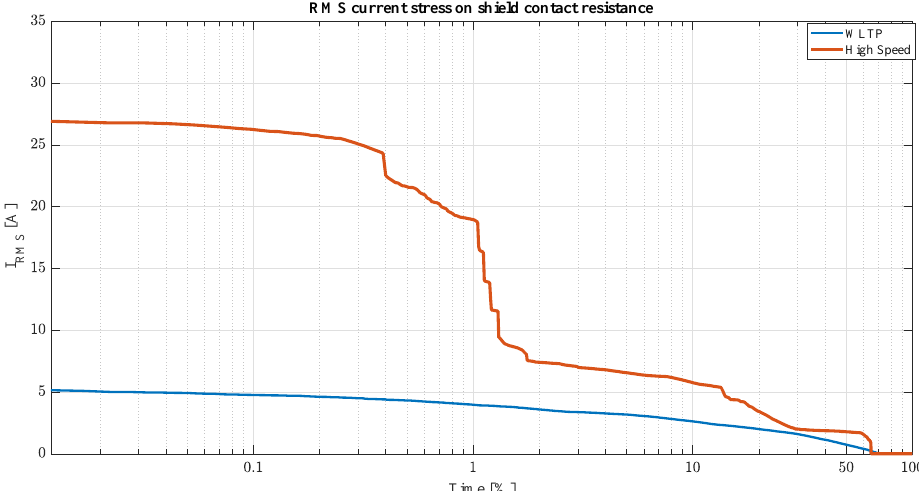
Figure 13. Simulated current levels of HV system currents over a WLTP-WLTC Class3 drive cy- cle, where the actual state of the electric drive-train and the DC voltage is based on real vehicle measurements. Simulations showed the presented current levels.